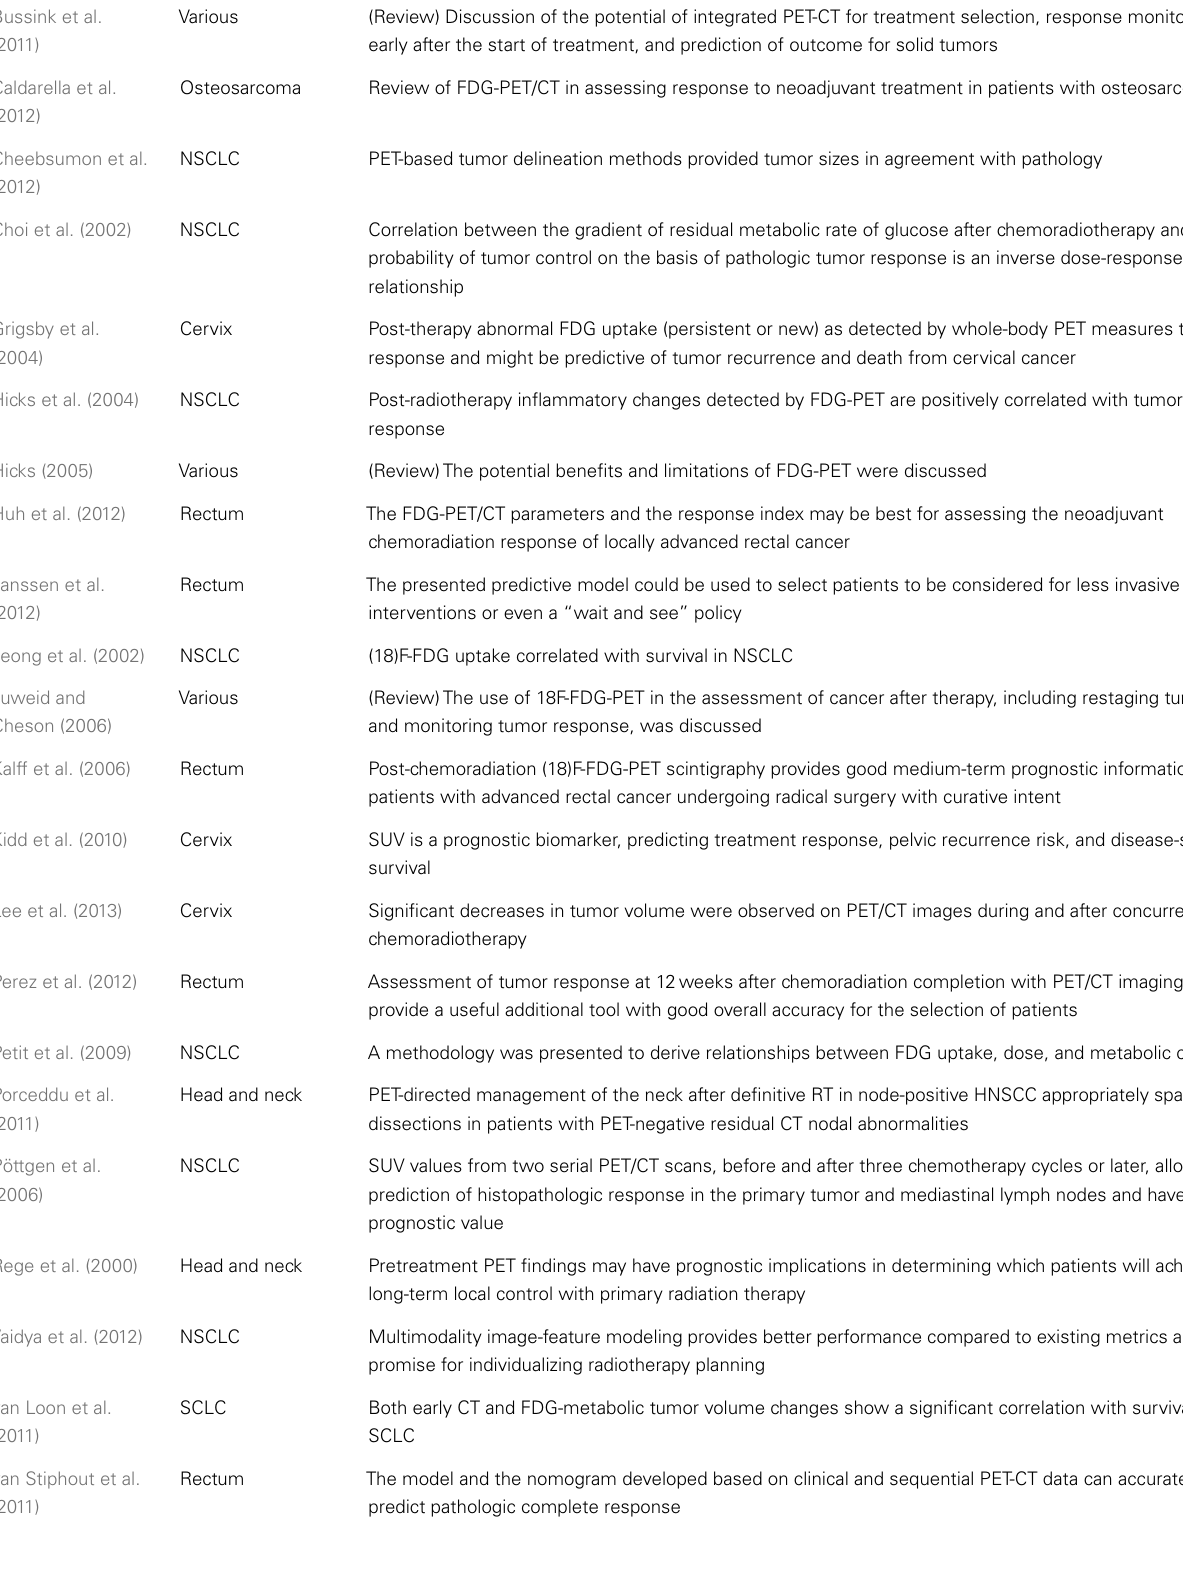
Table 2 |Application of PET/CT in radiation treatment